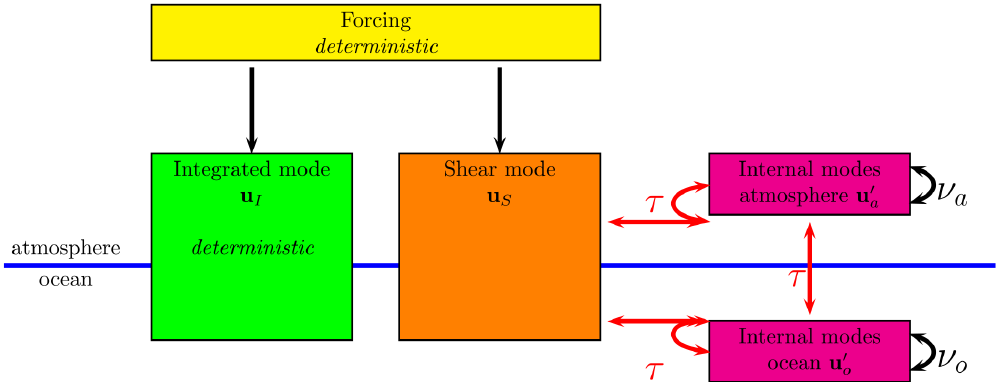
Figure 1. Schematic of the models considered: the integrated mode and the shear mode are forced. The integrated mode is decoupled from the rest of the dynamics. The shear mode is coupled to the internal modes of the atmosphere and the ocean by the surface stress. The internal modes in the atmosphere and the ocean depend on the eddy viscosity in each layer and the surface stress. The randomness arises through the surface friction τ (red color). In the 1D model the internal dynamics in the atmospheric and oceanic layer are explicitly resolved and random noise is added to the surface friction coefficient. In the 0D model their influence on the shear mode is parameterized by random